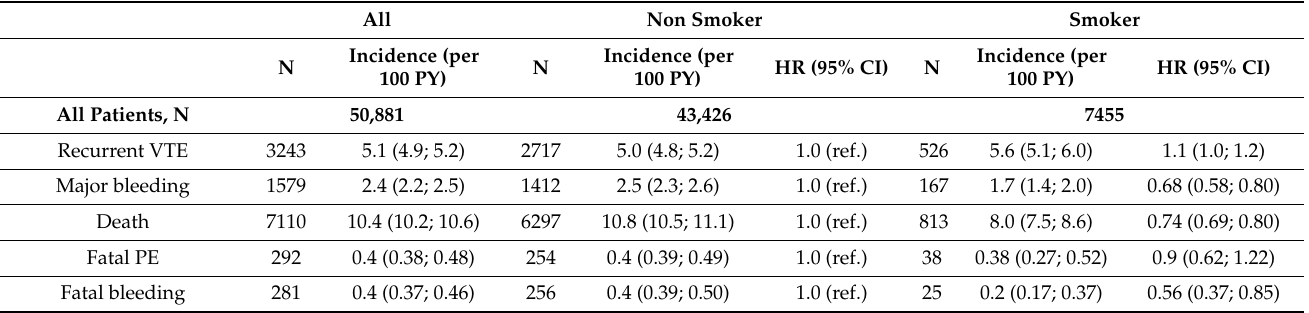
Table 3. Clinical outcomes during anticoagulant therapy in the whole sample and according to smoking